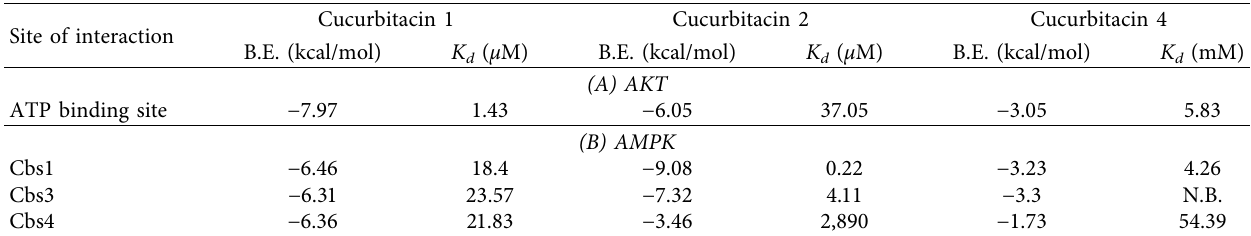
Table 2: Results of docking analysis of cucurbitacins 1, 2, and 4 with (A) the active site of AKTand (B) cystathionine β -synthetase (CBS) sites of